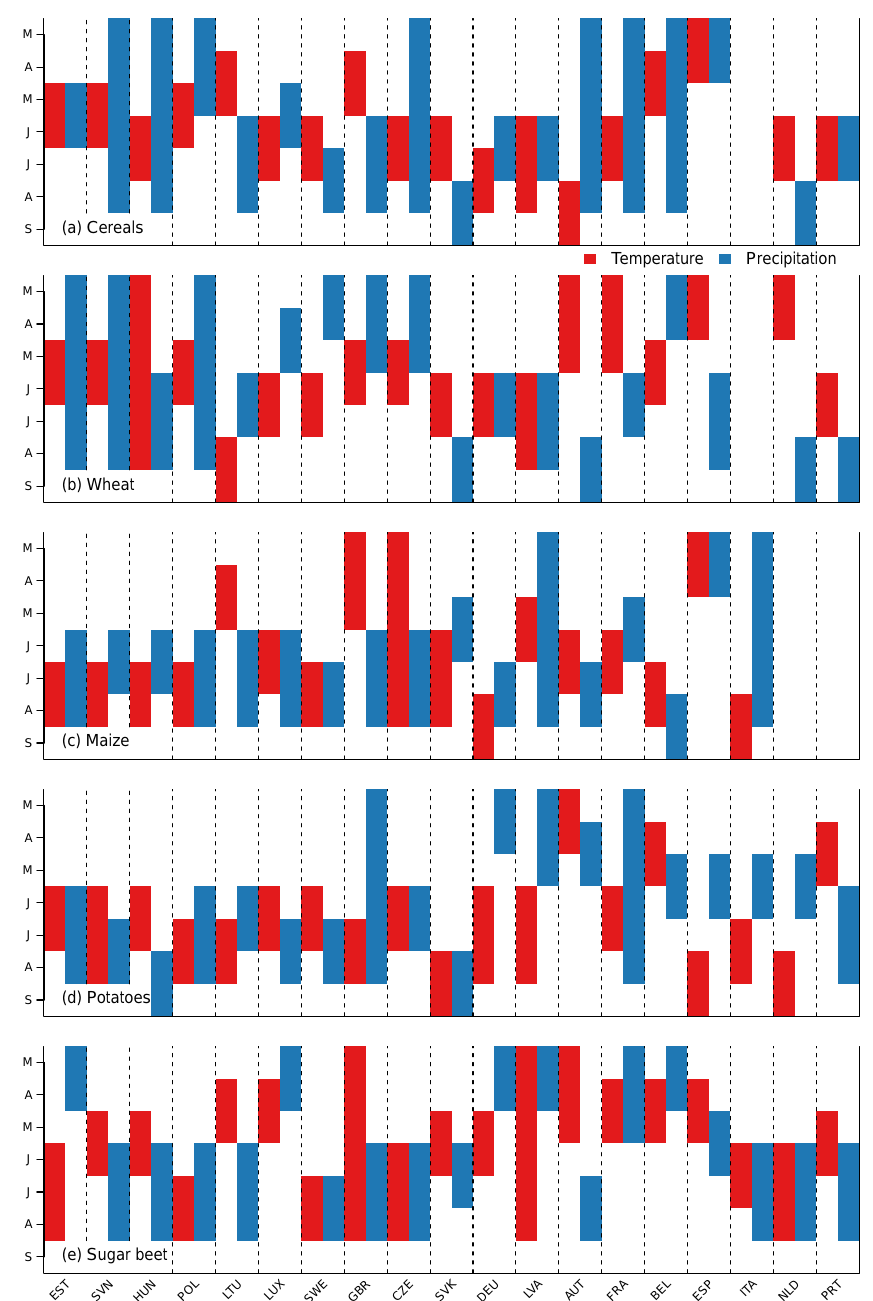
Figure 6. Summary of which months are selected to obtain the model with the best performance based on bivariate return periods of temperature and precipitation ( M rp ). Months range from March until September. Red bars denote temperature, blue bars